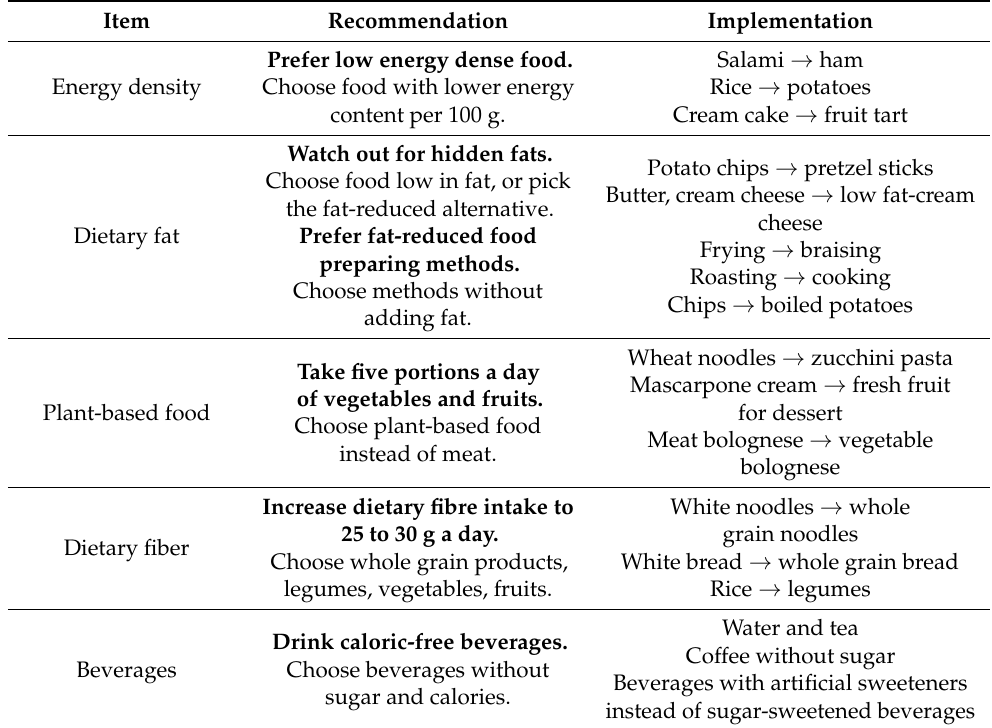
Table 2. Practical recommendations and examples to reduce energy